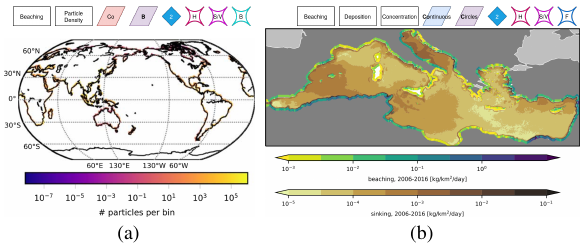
Figure 4. Coastline data. a) (Wichmann et al., 2019a), fig. 7, Initial particle positions. b) (Kaandorp et al., 2020), fig. 4, Particles ending their trajectory on the